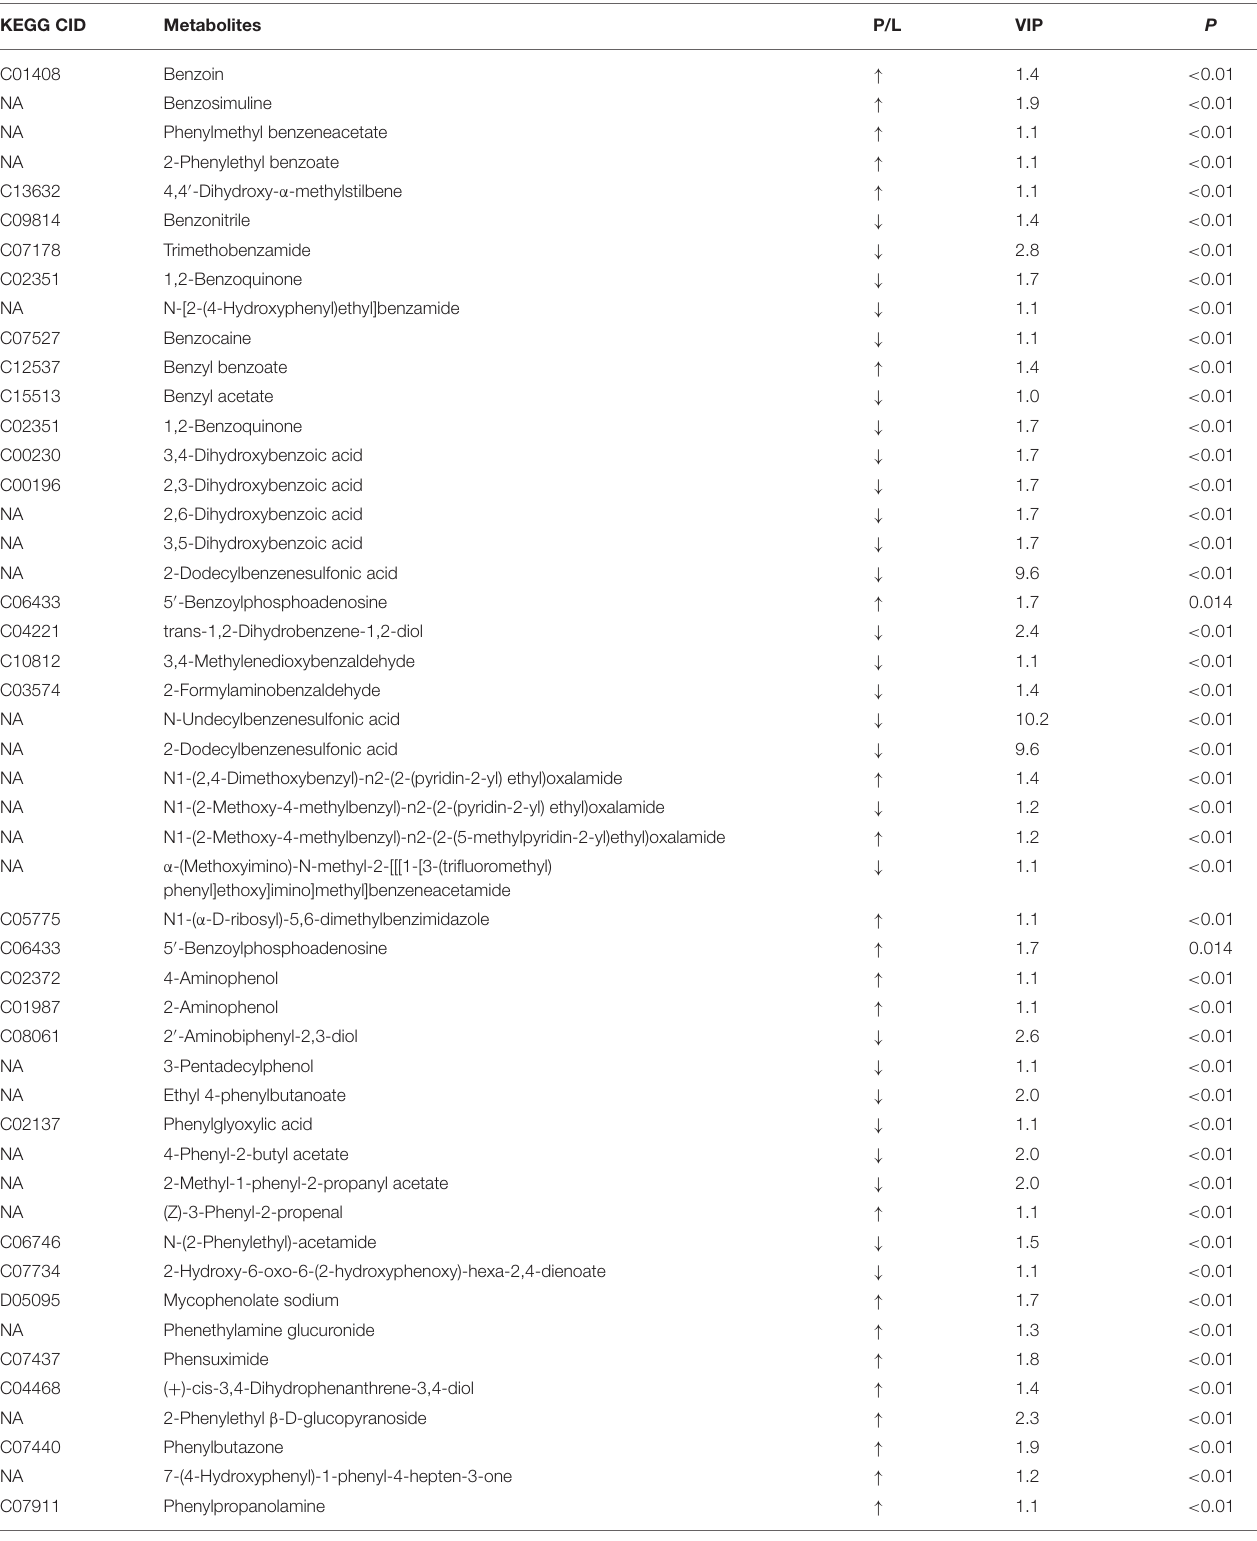
TABLE 4 | Differential xenobiotics with higher levels in controls than antibiotic-fed pupae in negative ion mode. KEGG CID Metabolites P/L VIP P